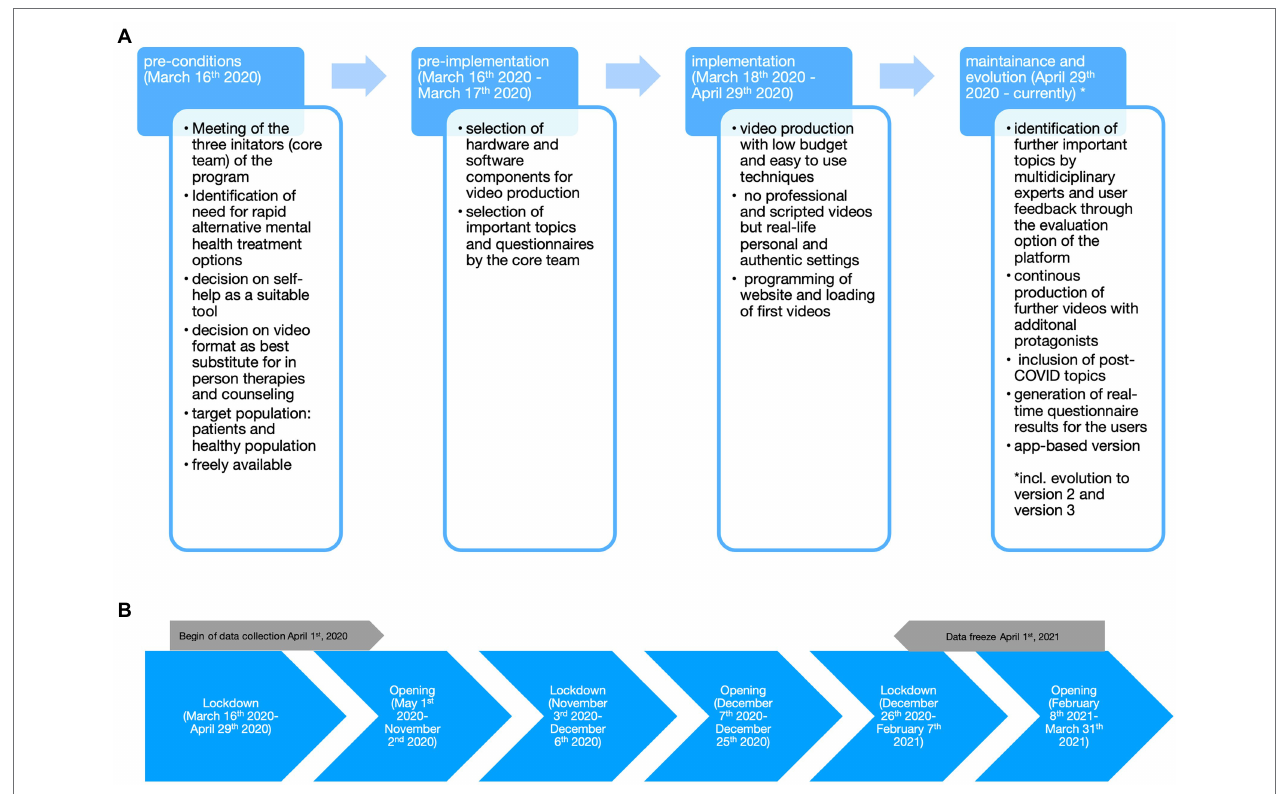
FIGURE 1 | Components of the Replicating Effective Programs (REP) framework for the implementation of an online mental health self-help program and depiction of pandemic phases in Austria. (A) The different implementation phases are indicated (blue background) and the steps taken during the implementation of the current online mental health self-help program are described below in a general overview. (B) This figure shows the different lockdown and opening phases which took place during the first year of the pandemic in